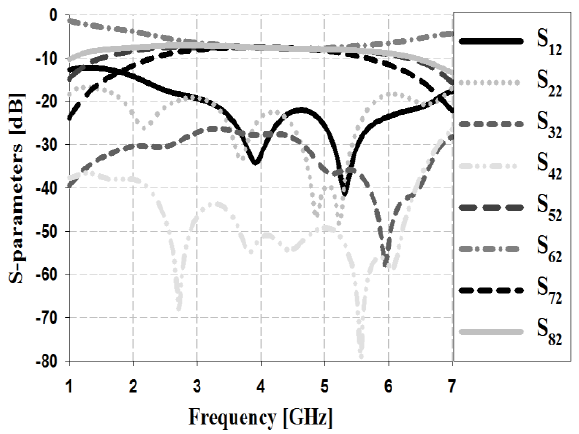
Figure 11. Simulation analysis of S-parameters for input Port 2.